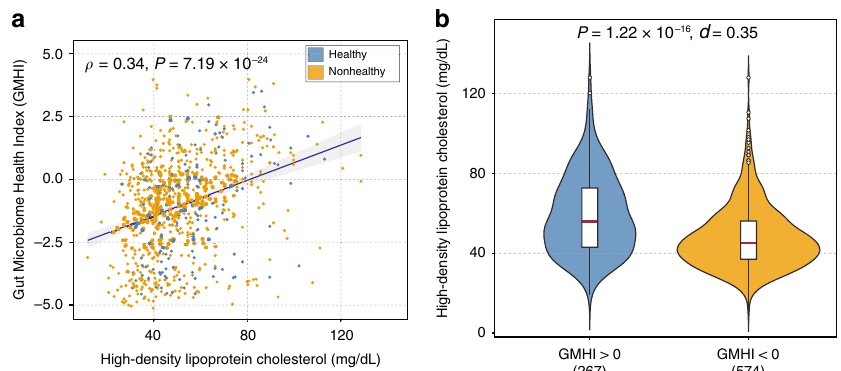
Fig. 2 GMHI is associated with high-density lipoprotein cholesterol (HDLC). a GMHI shows a moderately positive correlation with HDLC (Spearman ’ s ρ = 0.34, 95% CI: [0.28, 0.40], P = 7.19 × 10 − 24 ), which is a key parameter of cardiovascular health, in 841 subjects. b Signi fi cantly higher abundances of HDLC were observed in subjects with positive GMHI compared to those with negative GMHI (two-sided Mann – Whitney U test, P = 1.22 × 10 − 16 ). d Cliff ’ s Delta. The sample size of each group, whose subjects ’ HDLC records were available in the original studies, is shown within parentheses. Standard box-and- whisker plots (e.g., center line, median; box limits, upper and lower quartiles; whiskers, 1.5× interquartile range; circles, outliers) are used to depict groups of numerical